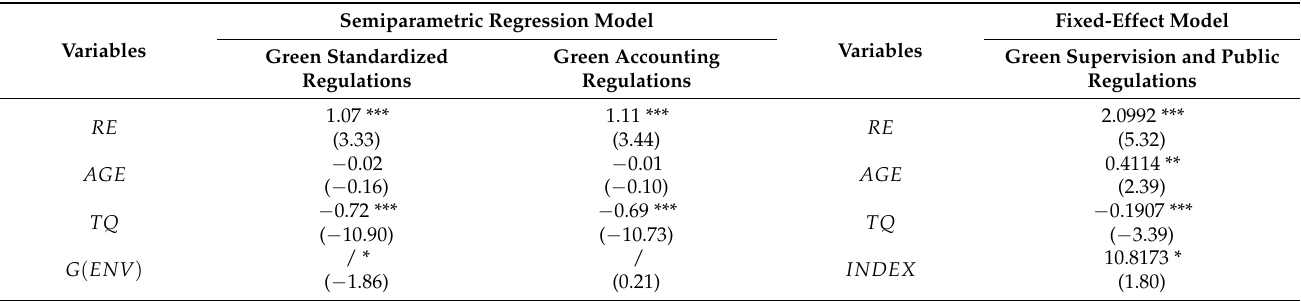
Table 6. Estimation for three kinds of environmental